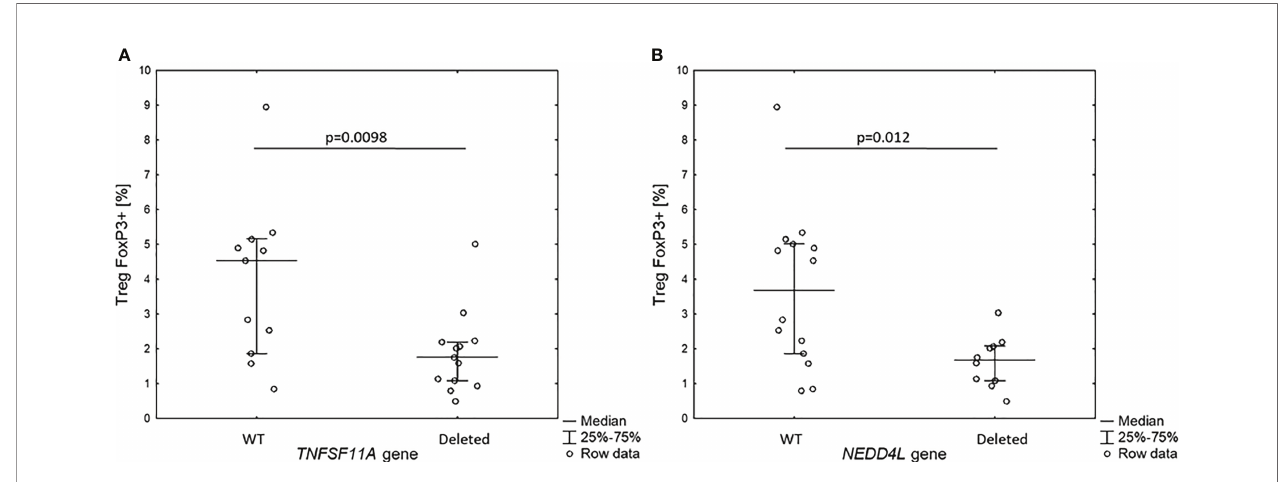
FIGURE 3 | Percentage of Treg FOXP3+ cells in 18q del patients without and with haploinsuf fi ciency of TNFSF11A (A) and NEDDL4 genes (B)